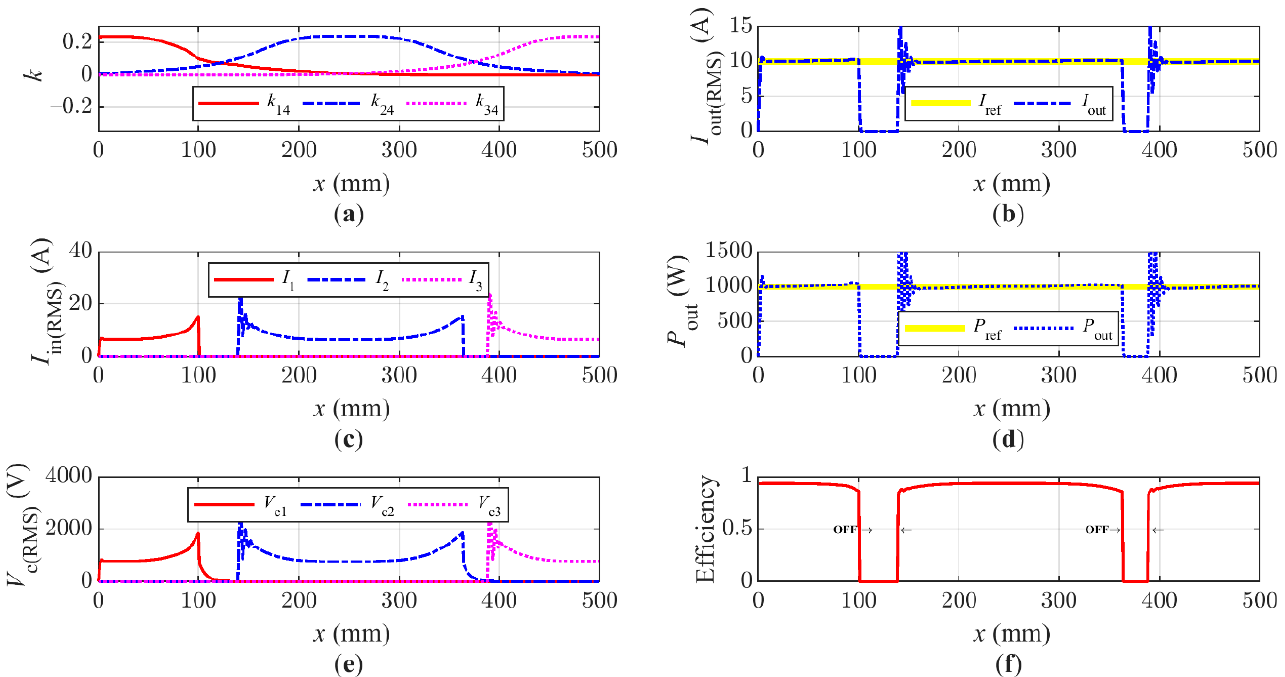
Figure 9. Second solution: ( a ) coupling coefficients k 14 , k 24 and k 34 ; ( b ) output current I out(RMS) ; ( c ) input currents I 1(RMS) , I 2(RMS) and I 3(RMS) ; ( d ) output power P out(RMS) ; ( e ) voltages on the primary side capacitor V c 1(RMS) , V c 2(RMS) and V c 3(RMS) ; ( f ) system efficiency.